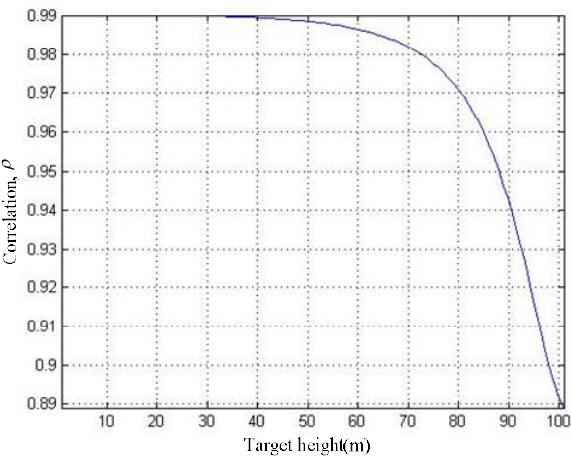
Figure 12. h – ρ curve.